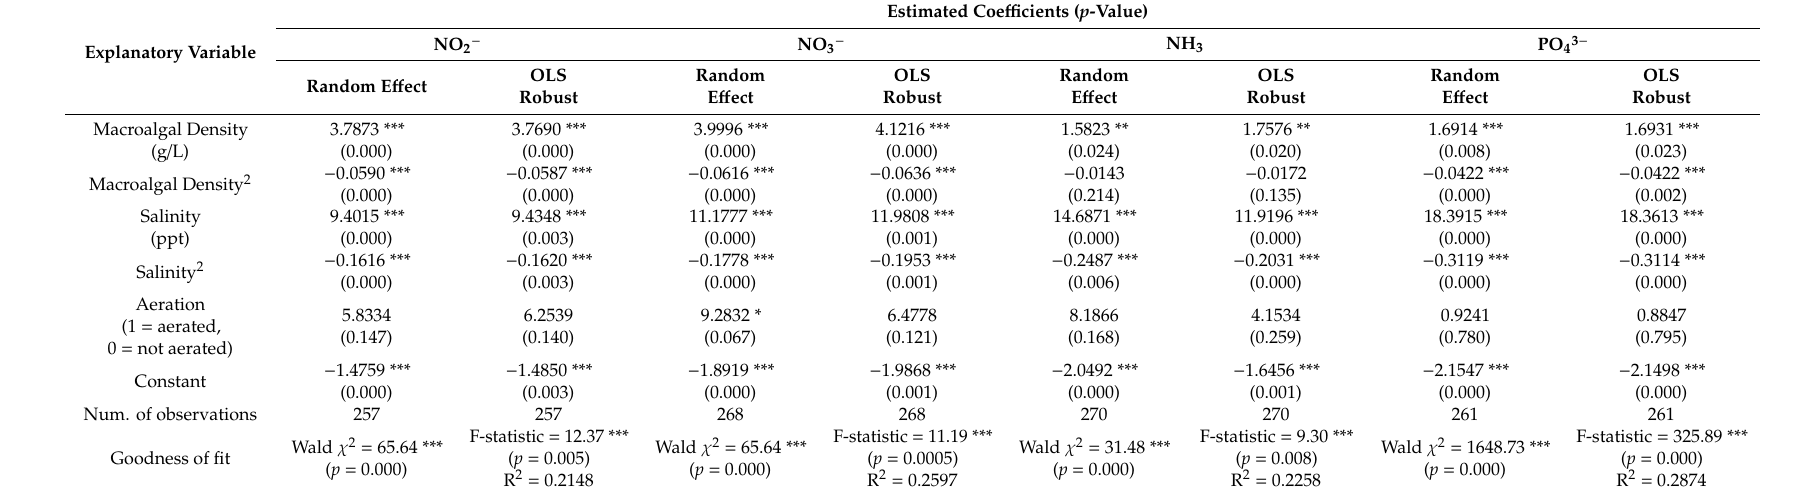
Table 4. Regression results on the determinants of nutrient uptake by Caulerpa lentillifera